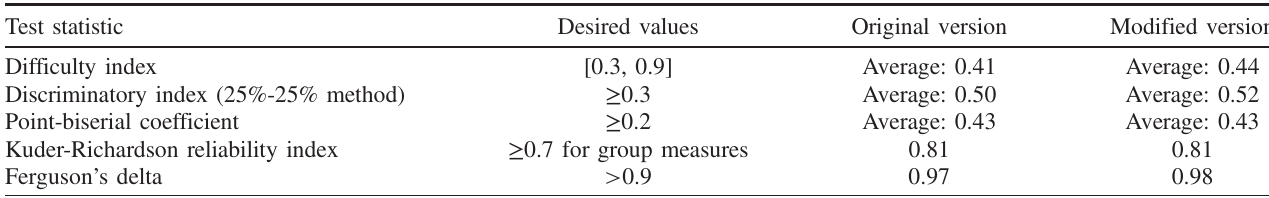
TABLE IV. Summary of the results of the five statistical tests suggested by Ding et al. [35] for the original and modified versions of the